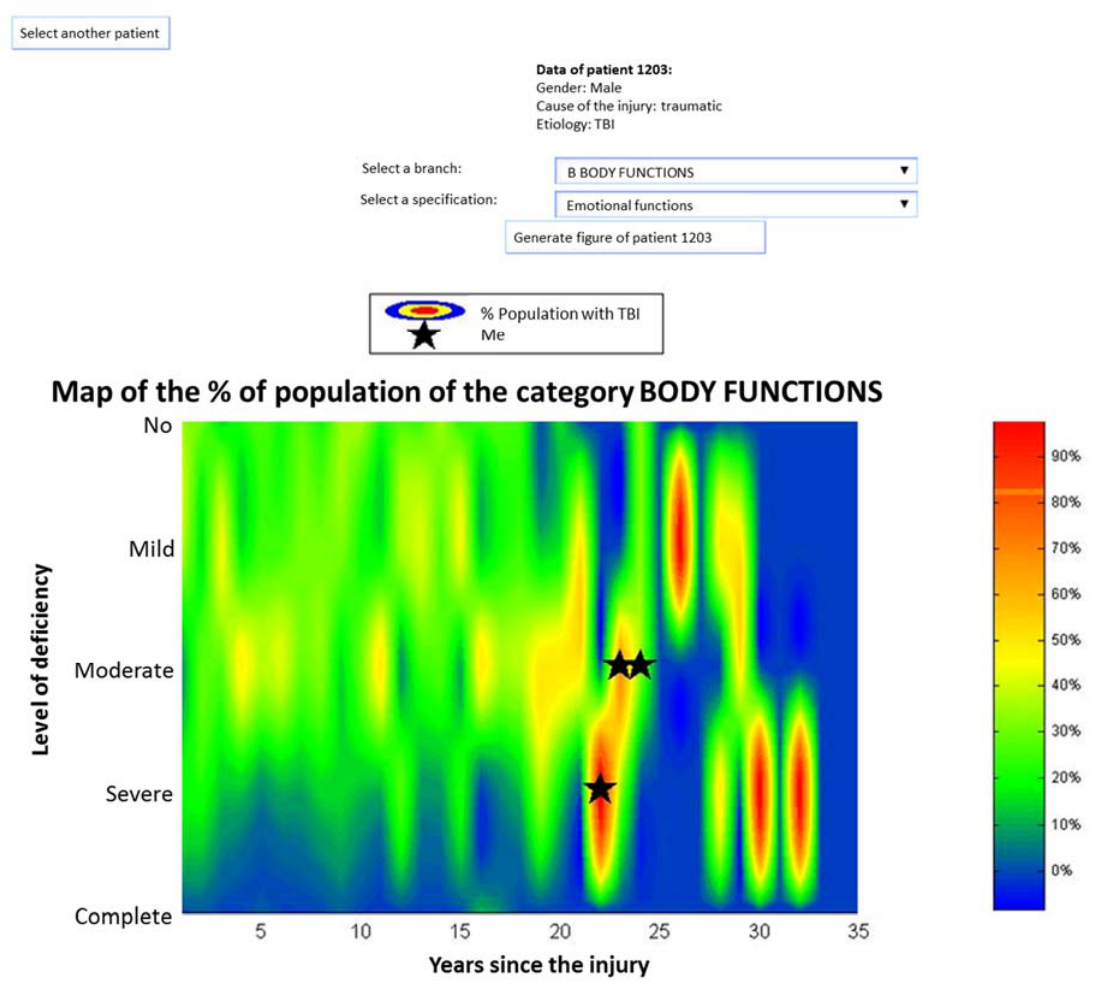
Figure 4. Graphical representation of the evolution of a population with TBI through ICF